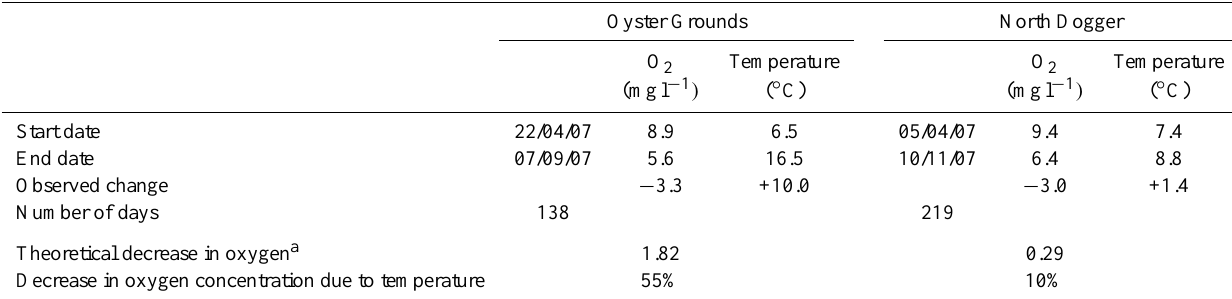
Table 3. Contribution of increasing temperature on decreasing oxygen concentration in the bottom mixed layer at Oyster Grounds and North